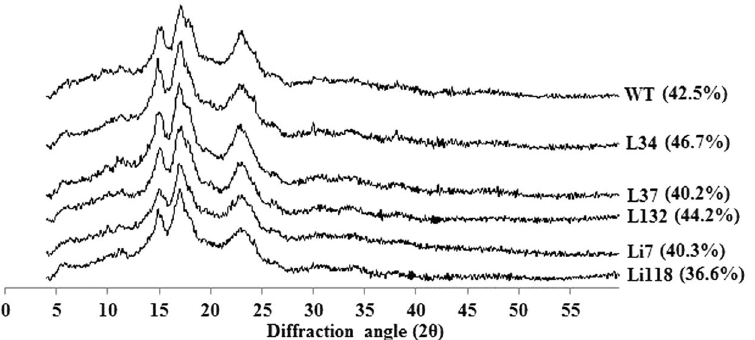
Figure 8. Wide-angle X-ray powder diffraction spectra for starches from WT and different transgenic lines. All the starch samples showed typical A-type crystal pattern. The percentage in the parentheses are the degree of crystallinity.